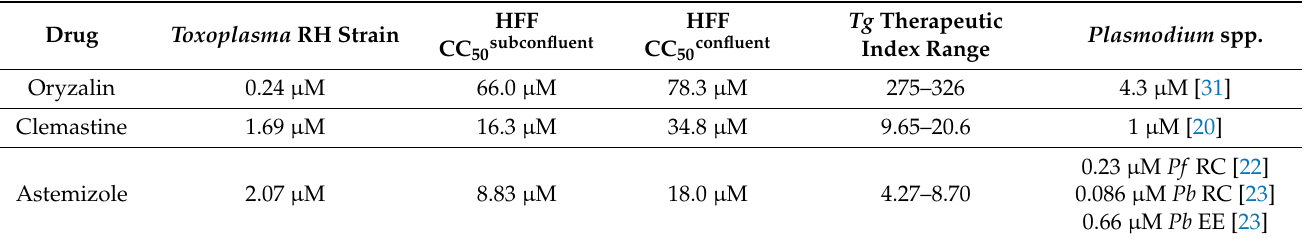
Table 1. Test-compound efficacy and cytotoxic